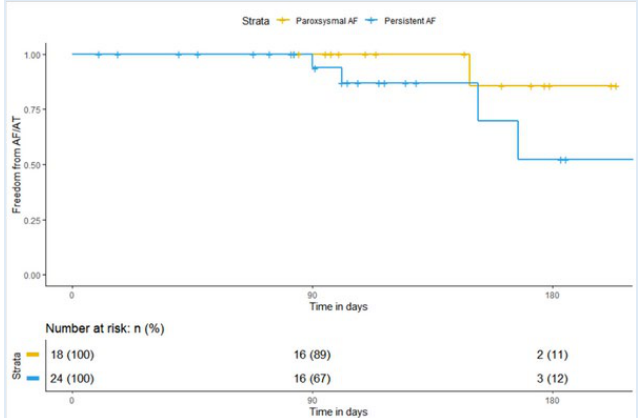
Figure: Time domain (upper row) and corresponding frequency domain representation (lower row) of representative signals of the three classes from the same patient between two blue vertical lines. With a local PV- NF, high-frequencies are visible, as illustrated between the blue vertical lines highlighting the 150 to 350 Hz frequency band in the left and right lower